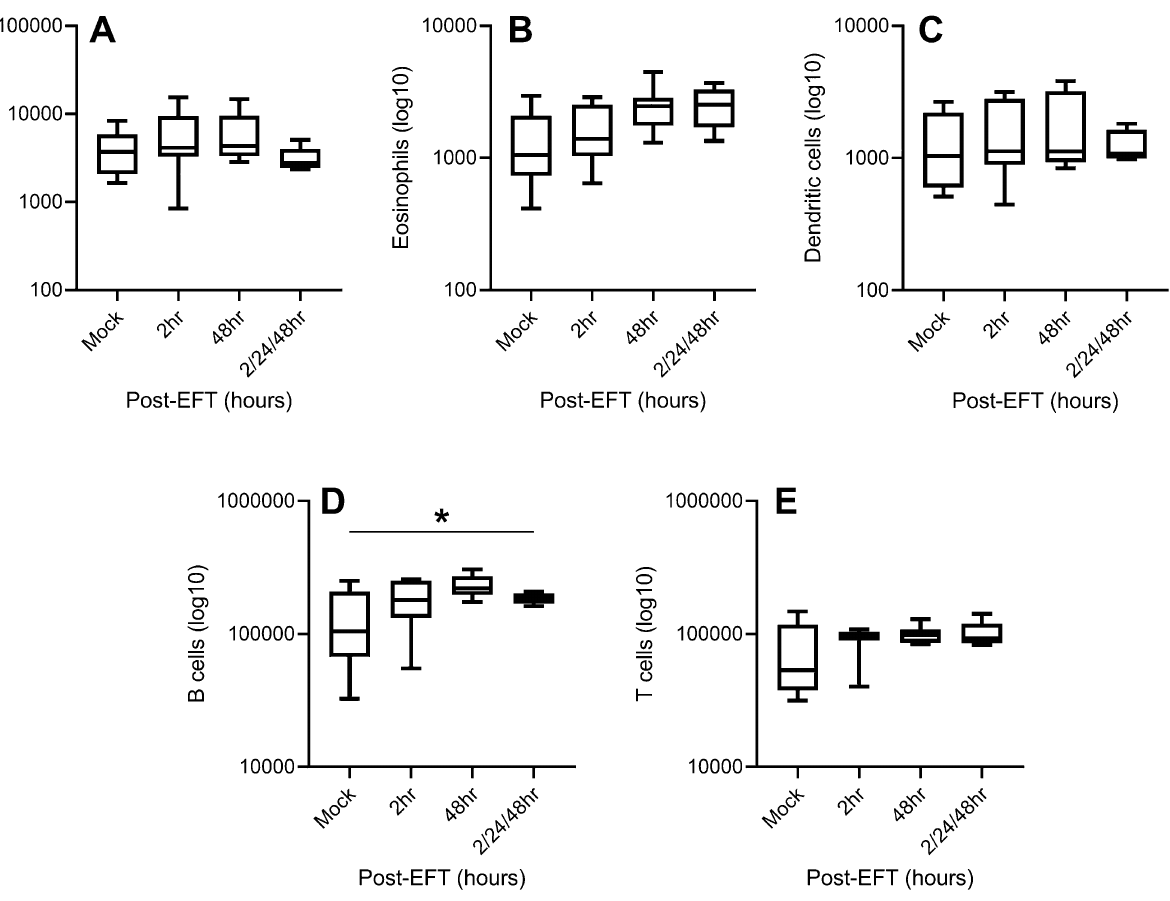
Figure 3. Analysis of spleen immune cells after EFT. EFT was administered in a single dose and mice sacrificed 2 and 48 h afterward, or EFT was given three times at 48, 24, and 2 h before sacrifice. Spleen cellular analysis by flow cytometry for ( A ) neutrophils, ( B ) eosinophils, ( C ) dendritic cells, ( D ) B lymphocytes, and ( E ) T lymphocytes is shown. Data are n = 5–8 for each group at each time point. Boxes are median line with first and third quartiles, min/max shown with brackets. * p < 0.05 by